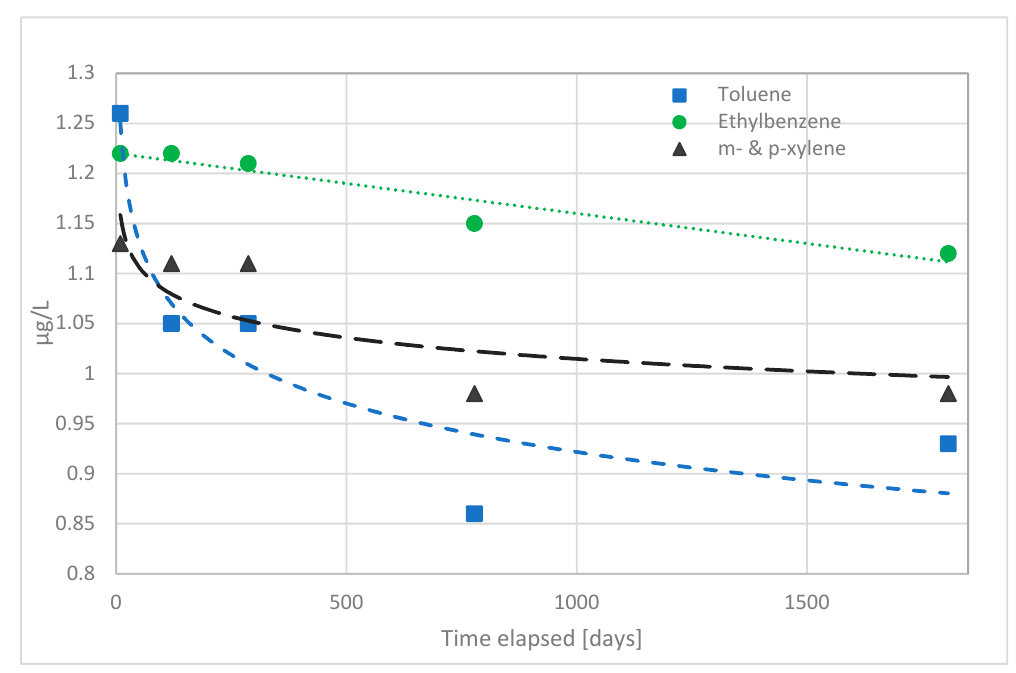
Figure 5. The measured concentrations of ethylbenzene, m-xylene and p-xylene in the water entering the office building during the first five years use.